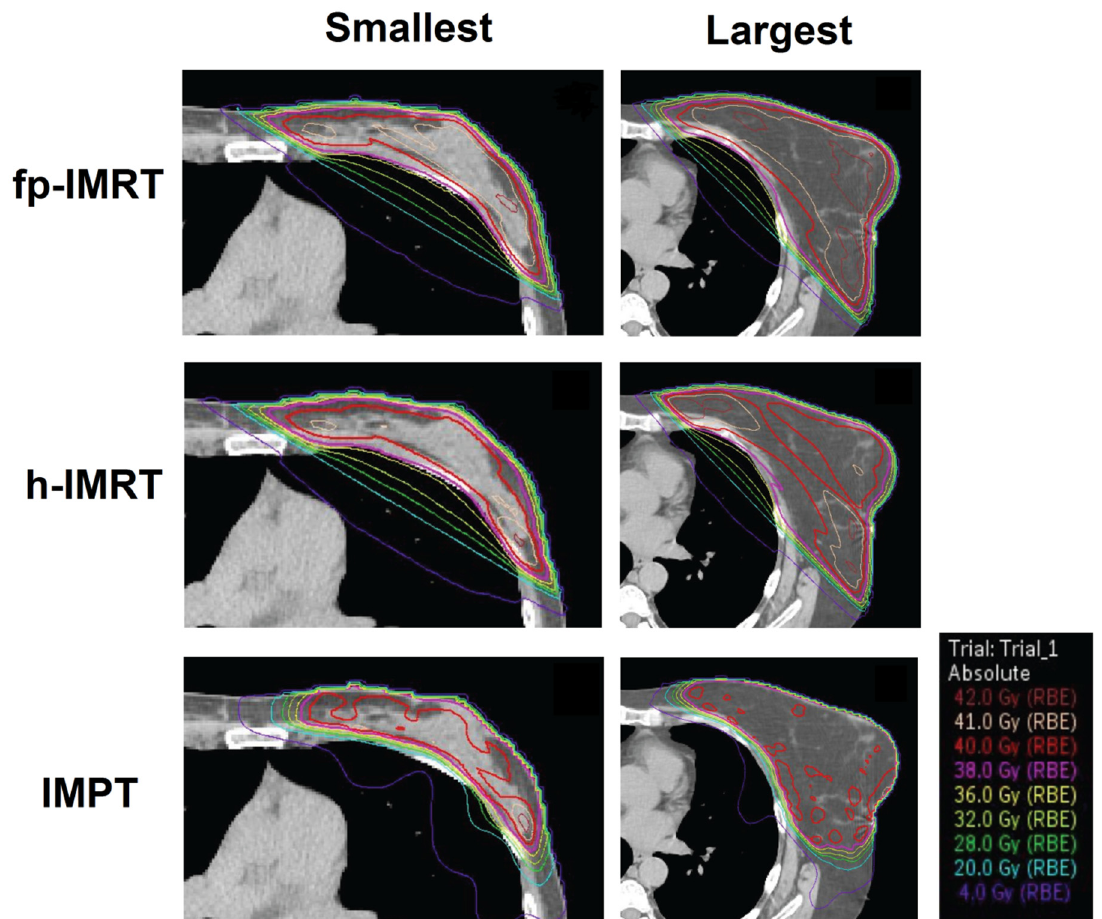
Figure 3. Dosimetry through the central transverse slice of each technique for two patients (smallest and largest breast size). Abbreviations: fp-IMRT—forward planned intensity-modulated radiation therapy; h-IMRT—hybrid intensity-modulated radiation therapy; IMPT—intensity modulated proton therapy.